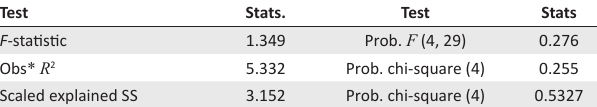
TABLE 7: Heteroskedasticity test: